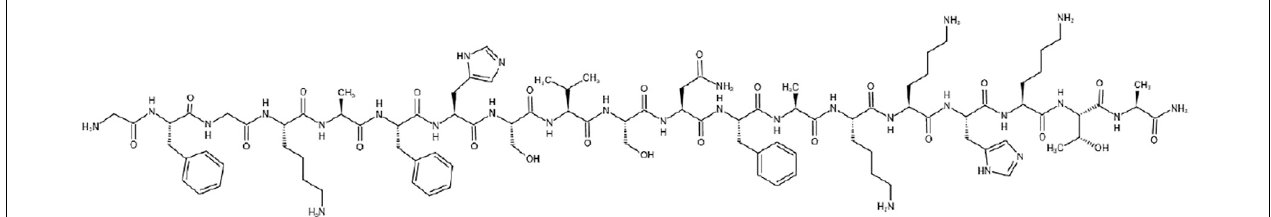
FIGURE 2 | The chemical structure of Styelin